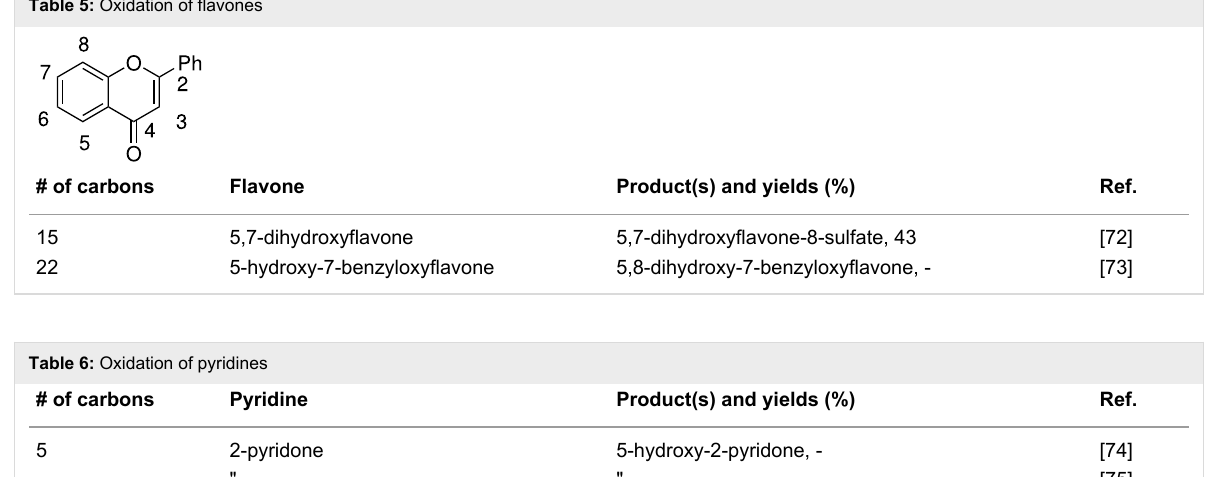
Table 6: Oxidation of pyridines # of carbons Ref.